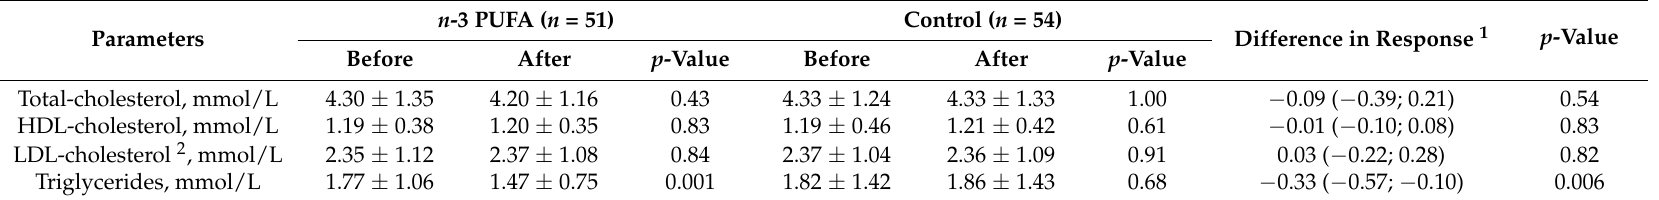
Table 3. Effects of n -3 PUFA on plasma lipids ( n = 105).